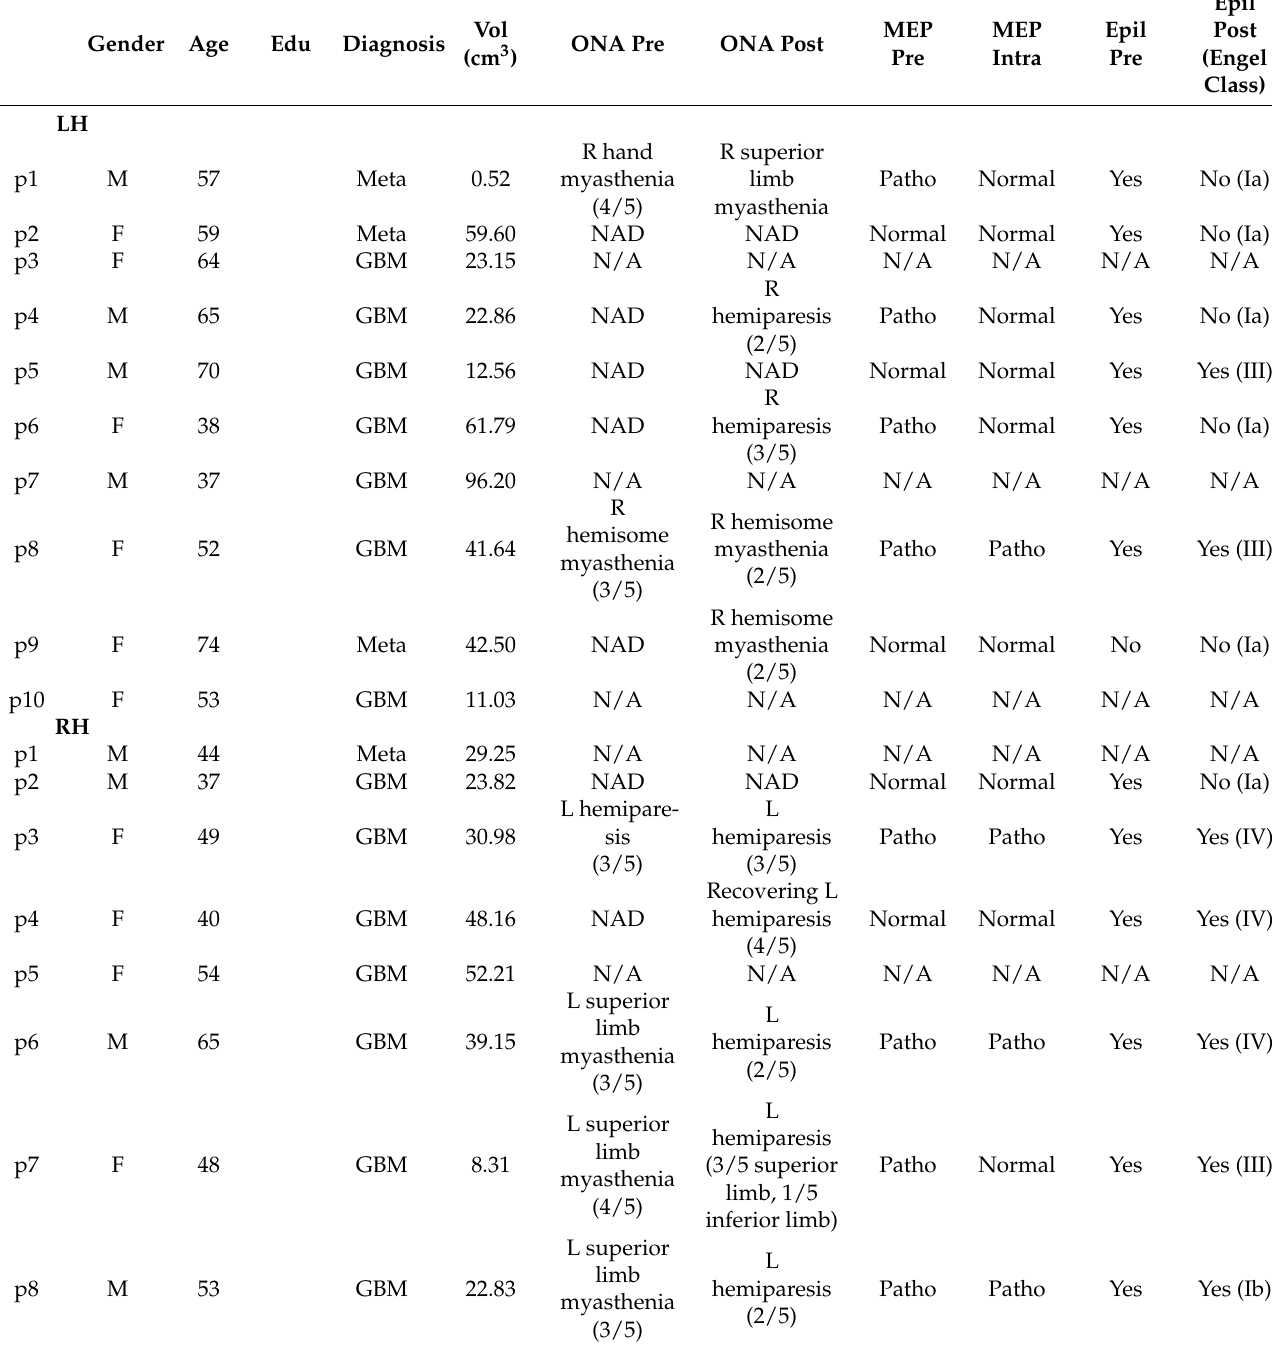
Table 1. Patients’ demographic and clinical